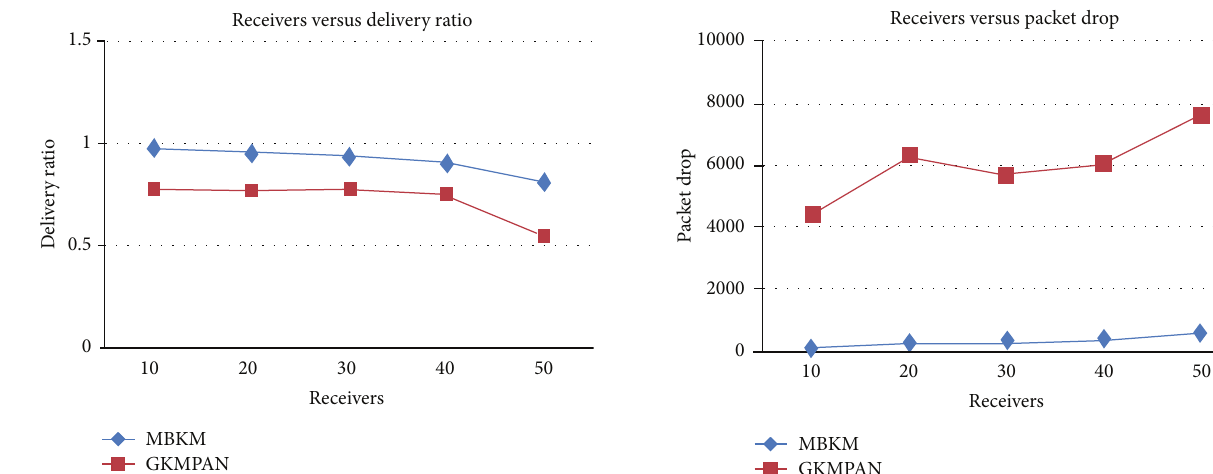
Figure 8: Comparison of packet drop with GKMPAN for varying receivers.